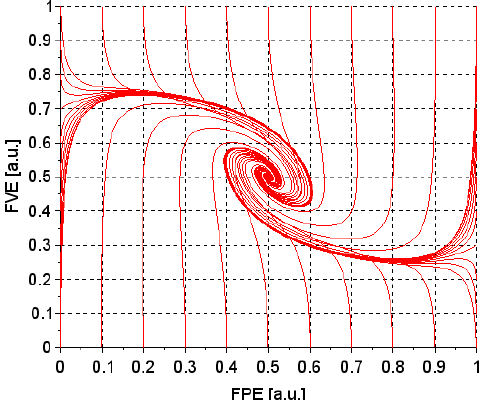
Figure 10. Trajectories for the initial states of state variables for the model with the fuzzy-logic